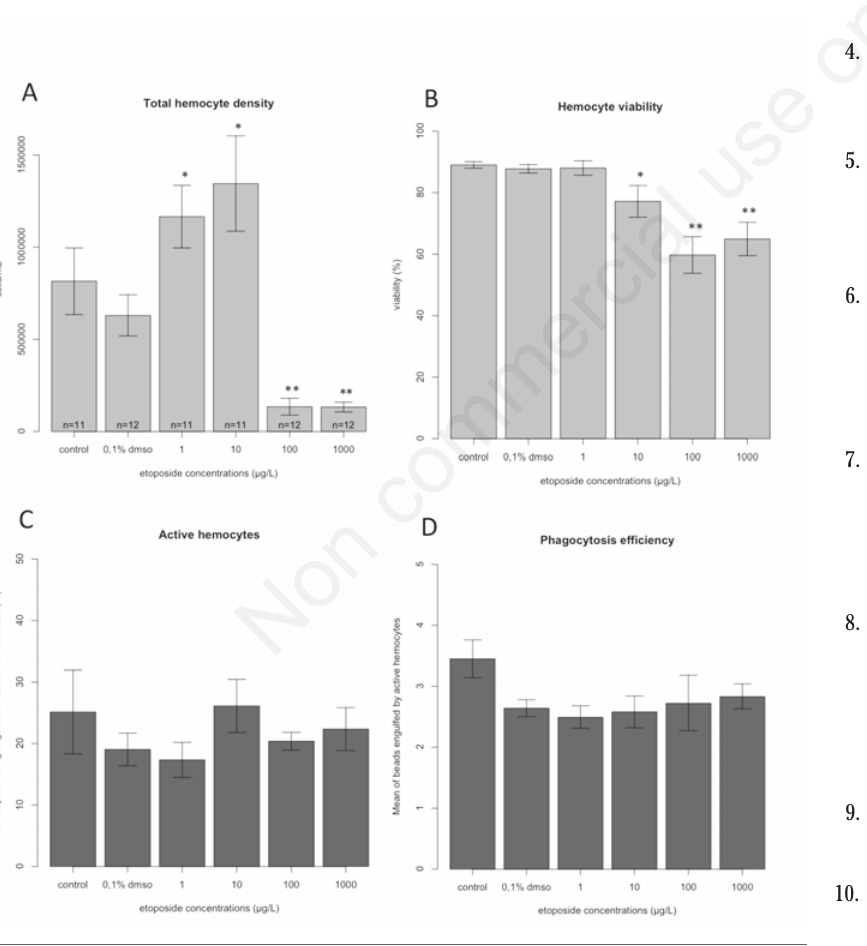
Figure 1. Effects of etoposide on immunocompetence of L. stagnalis . Snails were exposed to increasing concentrations of etoposide (1-1000 µg/L) for 72 h in glass beaker repli- cates with daily renewals. Afterwards, the hemolymph was collected individually and analyzed for determination of hemocyte concentrations (A), hemocytes viability (B), active phagocytes (C) and efficiency of phagocytosis (D). The barplots and error bars rep- resent the mean and standard error of the mean (SEM) of respective replicates per con- ditions. The number of snails per condition is indicated at the bottom of the barplots (A); differences correspond to snails that died during the